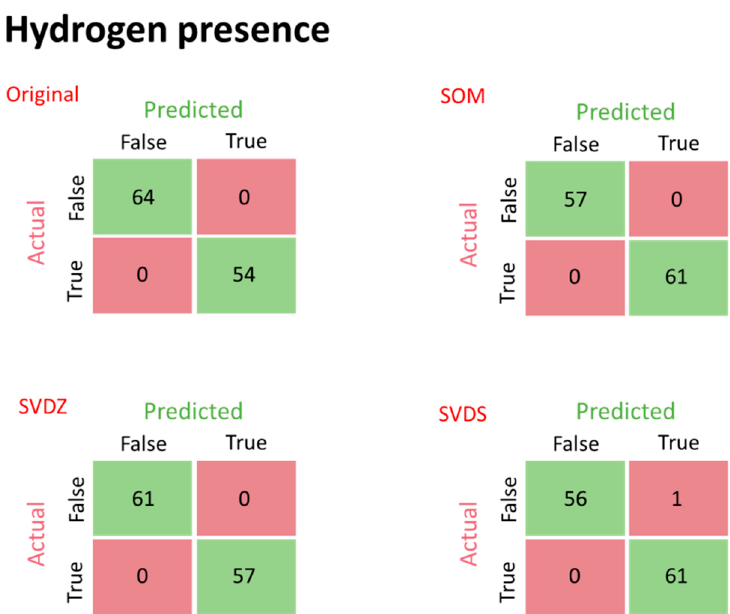
Figure 18. Confusion matrices demonstrating the accuracy of the two-dimensional images to generate images for training ANN model for classification, on presence of hydrogen impurity in the sputtering working gas. The SVD reconstruction of the SOM method demonstrated one inaccurate classification, while all other models performed with 100% accuracy.